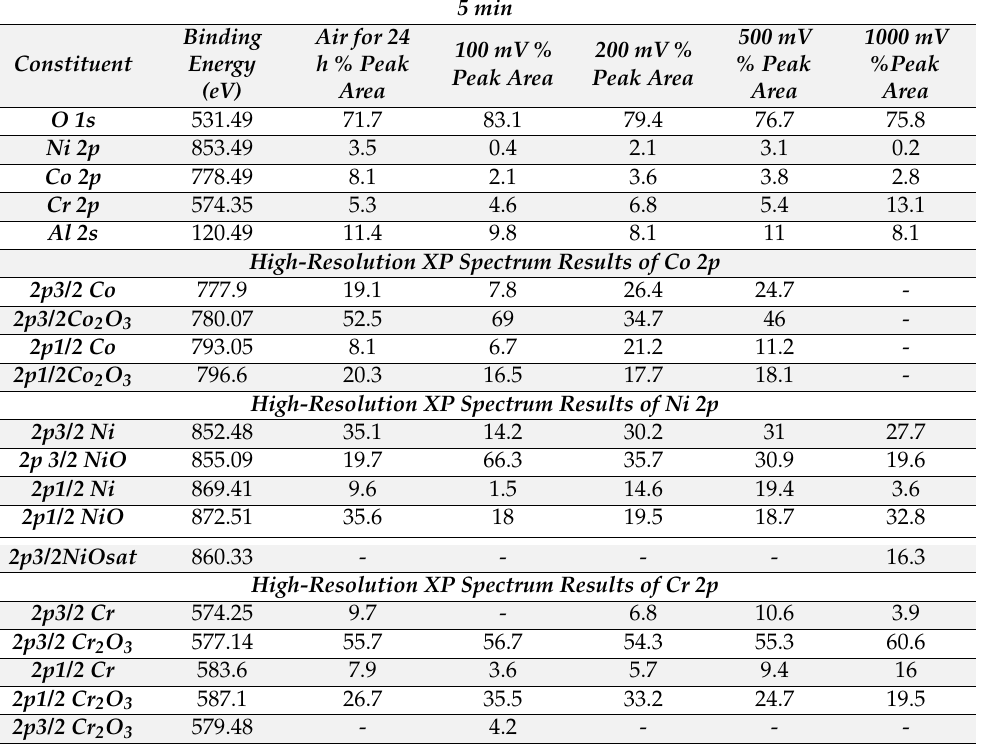
Table 8. Results data extracted from survey spectra and HR spectra. Polarization Condition: Polarization Was Carried Out at Constant Potential Polarizations